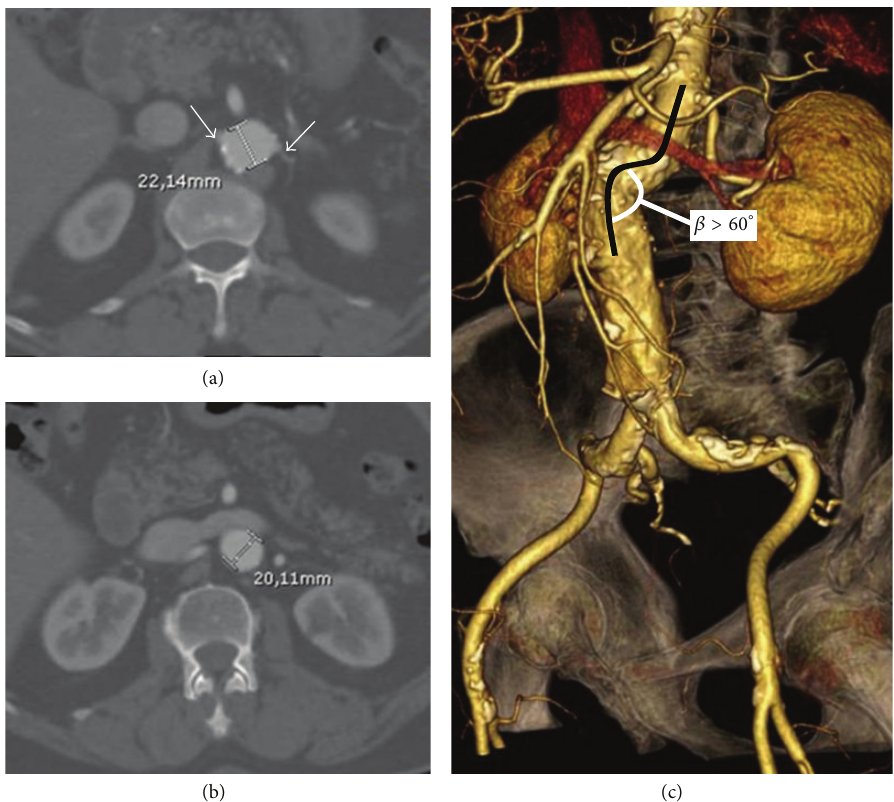
Figure 1: Preliminary CT-A showing (a, b) the reversed tapered shape of the proximal neck (arrows: renal arteries origin) and the severe 𝛽 -angle (c).